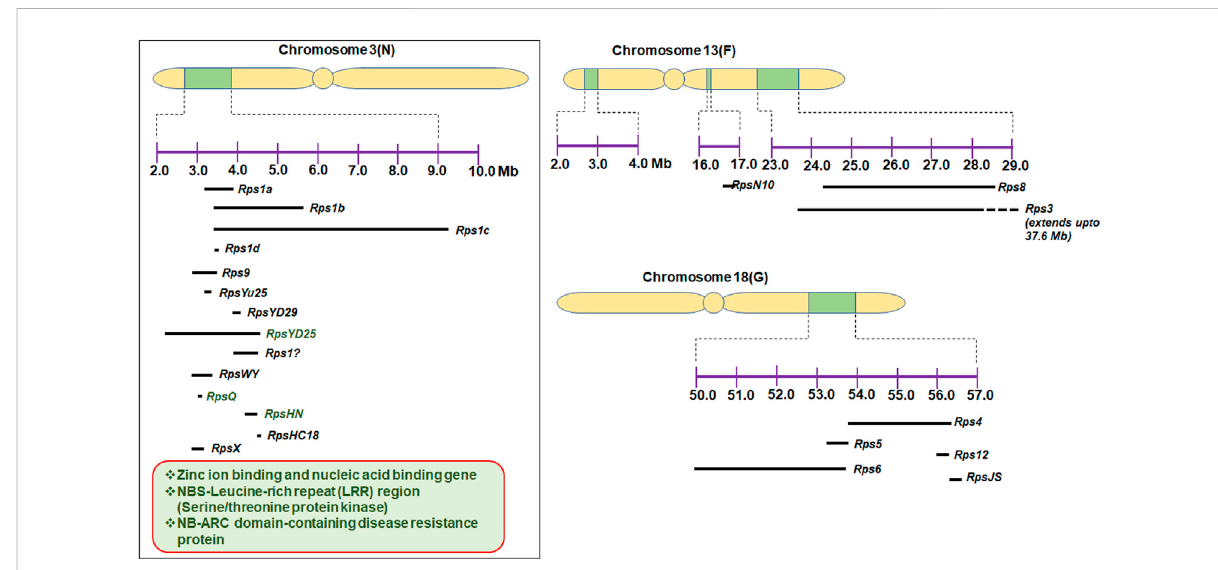
FIGURE 1 Genomic regions of chromosomes 3, 13, and 18, where more than 20 Rps genes were mapped; some potential characterized candidate genes are also depicted on chromosome